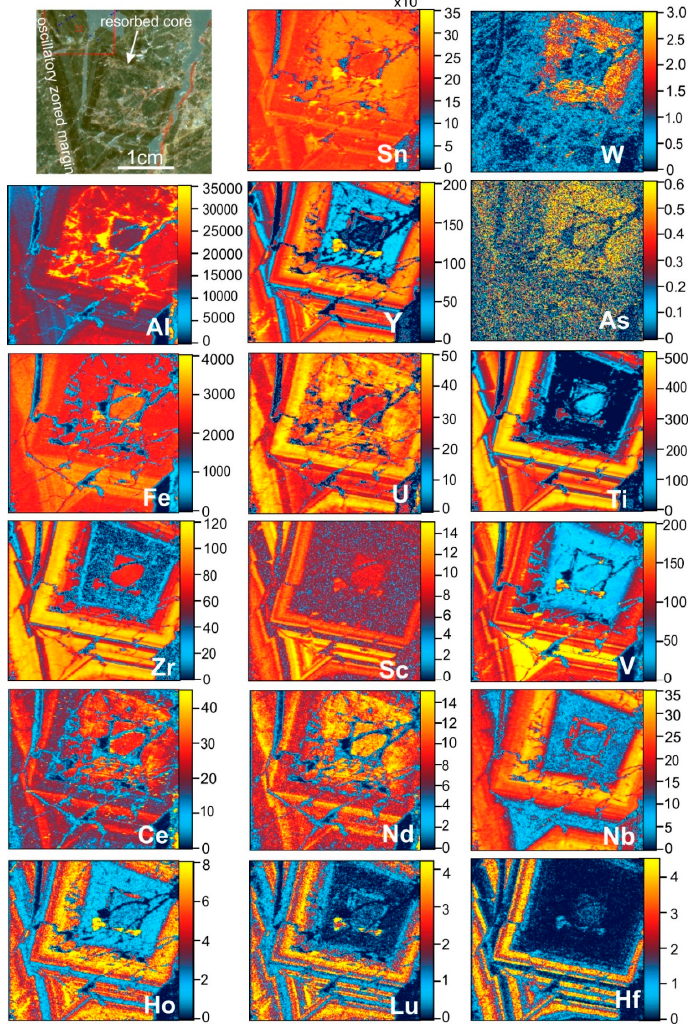
Figure 7. LA ‐ ICP ‐ MS element maps of zoned skarn garnet illustrating the abundance and diversity of trace elements present within the garnet structure. Scales in counts per second (×10 3 ). Measured isotopes: 118 Sn, 182 W, 27 Al, 89 Y, 75 As, 56 Fe, 238 U, 47 Ti, 90 Zr, 45 Sc, 51 V, 140 Ce, 146 Nd, 93 Nb, 165 Ho, 175 Lu, 178 Hf.